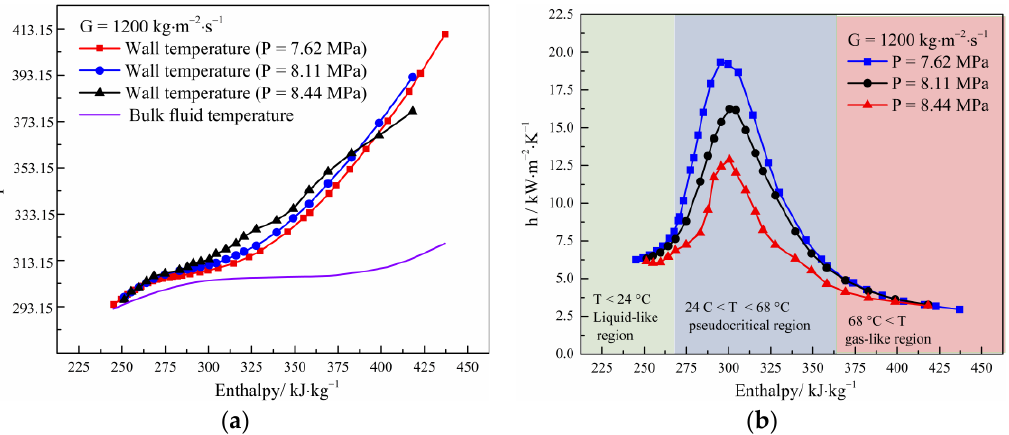
Figure 7. Variation of wall temperature ( a ) and heat transfer coefficient ( b ) with enthalpy under different pressures.